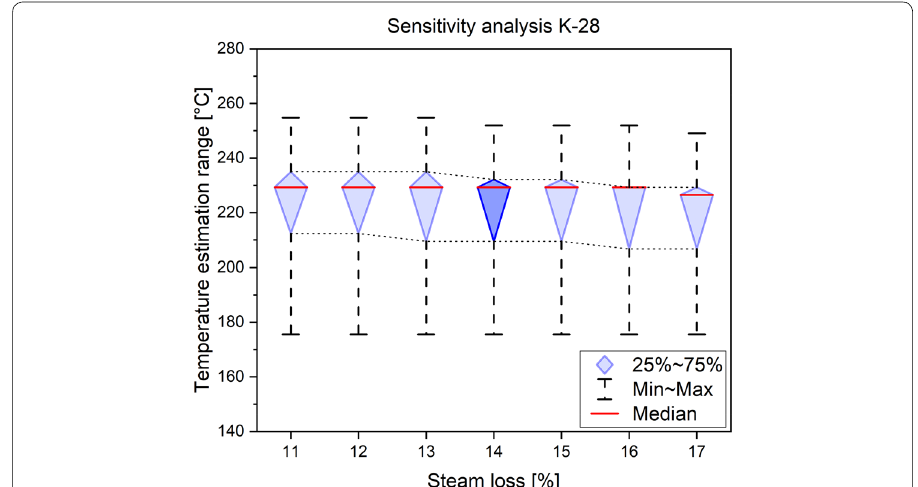
Fig. 5 Sensitivity analysis of steam loss for sample K-28. The value was varied in increments of 1%. The figure shows an extract of the data, where the steam loss ranges from 11 to 17% in increments of 1%. For 14% steam loss, the statistical minimum of the boxplot comparison is reached; it is highlighted in a darker blue colour